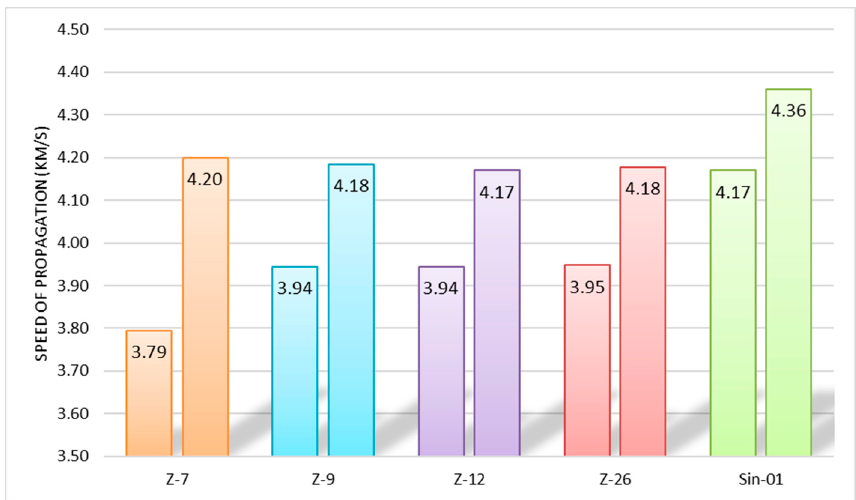
Figure 7. Results of ultrasonic pulse velocity (km/h) of the specimens at 7 and 18 days of age.